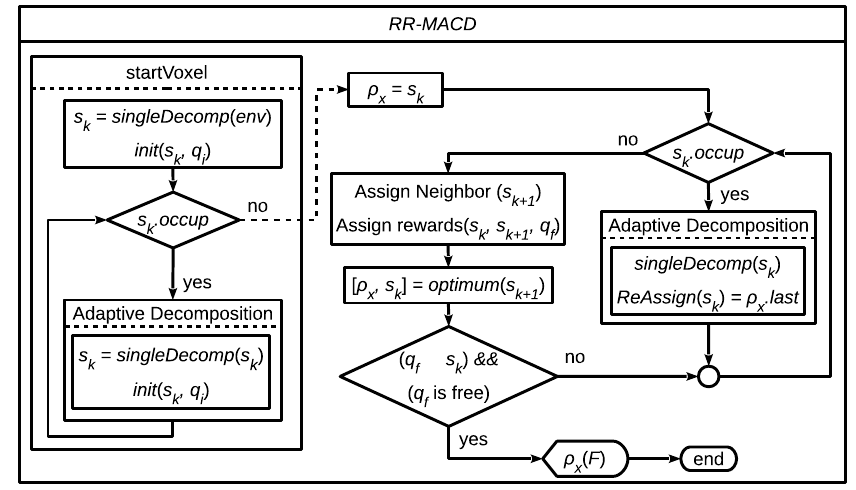
Figure 9. Flowchart of RR-MACD . Notice how steps 3 to 8 in Figure 2 are re-used in this chart and renamed as singleDecomp